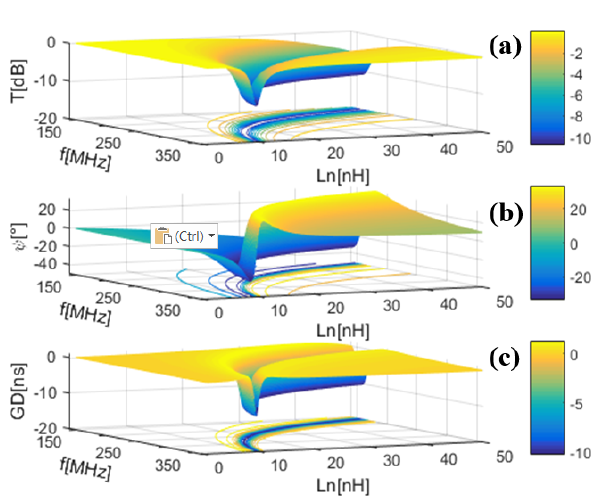
FIGURE 10. Variations of the VTF magnitude, phase and GD with respect to inductance L n variation in the range from 1 nH to 50 nH. From these 2-D plots, we can point up that: